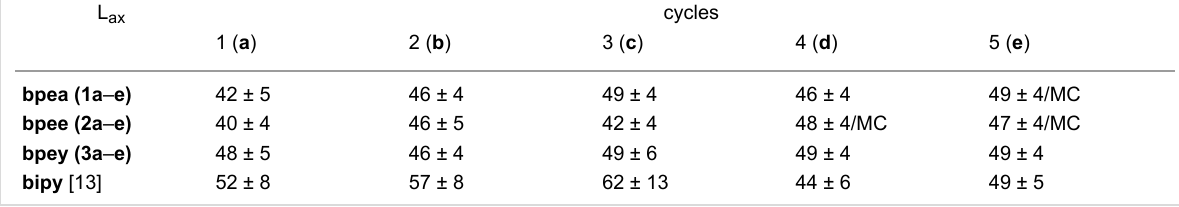
Table 1: Investigation of the core size [nm] and crystallinity of the CP-BCP composite obtained from TEM. “MC” denotes the observation of microcrys- tals. L